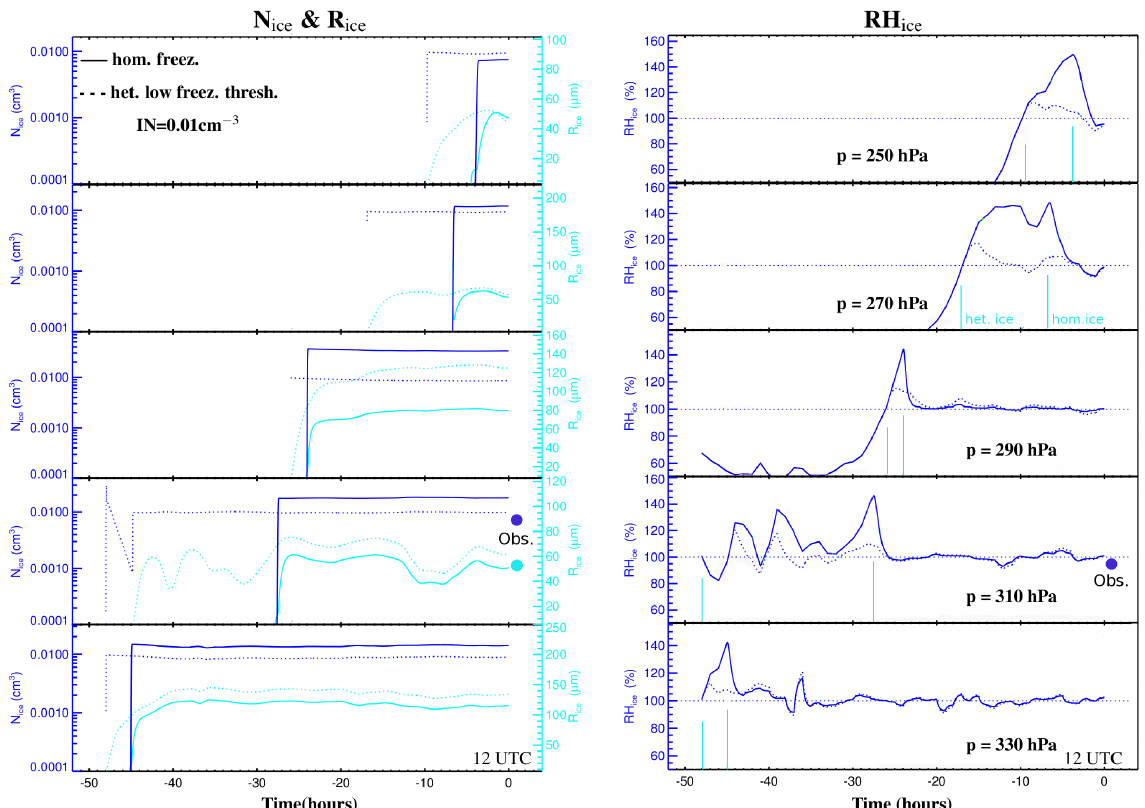
Fig. 11. MAID simulations along the trajectories shown in Figures 9 and 10 (solid line: homogeneous freezing, dotted line: heterogeneous freezing); N ice , MAID : number, R ice , MAID : mean mass size of ice crystals. In the 310 hPa panels, big dots denotes the observations (N ice , obs : peak number, R ice , obs : approximate size of ice crystals, see Figure 7, bottom panel; RH ice see Figure 6).